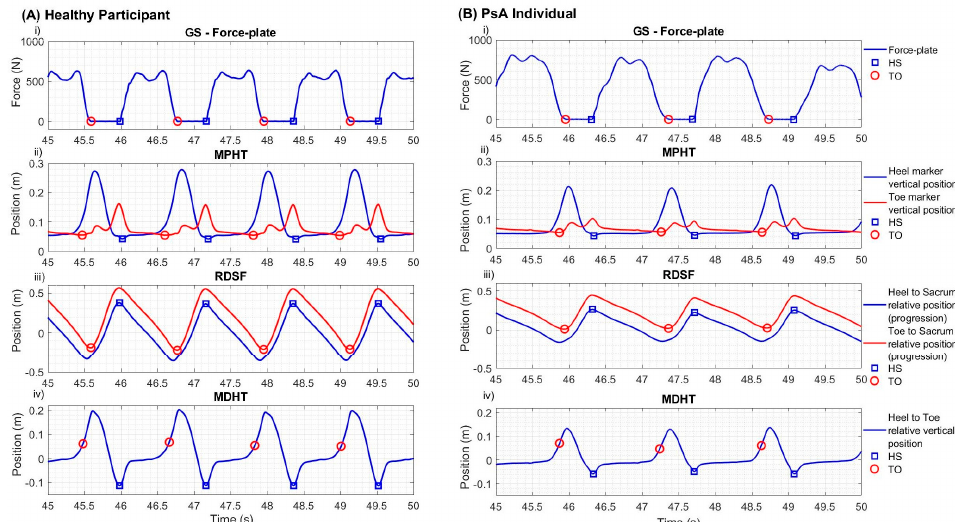
Figure 2. Representative filtered signals at normal speed walk for the three optoelectrical algorithms and the gold-standard force plate for ( A ) a healthy individual and ( B ) a PsA participant. For each class of participant: ( i ) gold-standard force plate signal (GS); ( ii ) vertical coordinates of the heel (blue) and toe (red) markers (MPHT); ( iii ) the resultant frontal coordinate formed by the subtraction of the frontal coordinate of the sacral marker from the frontal coordinate of the heel marker (blue) and resultant frontal coordinate formed by the subtraction of the frontal coordinate of the sacral marker from the frontal coordinate of the toe marker (red) (RDSF); ( iv ) the resulting signal formed by the subtraction of the vertical coordinate of the heel and toe markers (MDHT). In all subfigures, blue squares represent detected heel strikes, and red circles represent identified toe-offs.